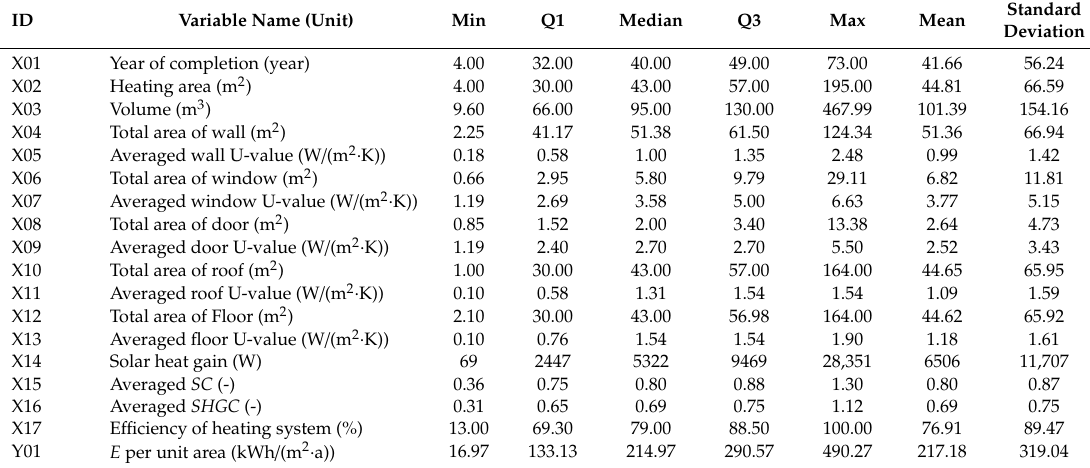
Table 3. Descriptive statistic.